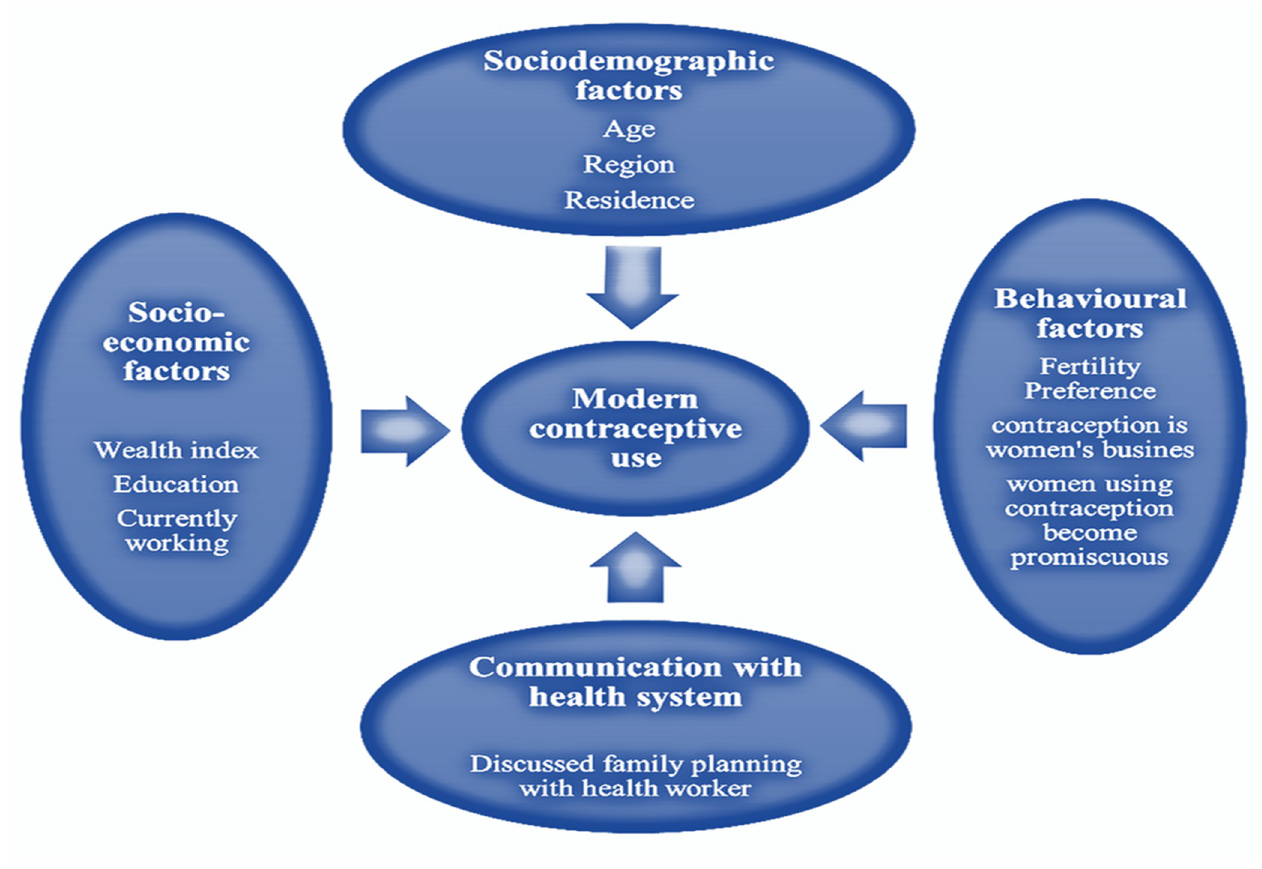
Fig 1. Schematic representation of study